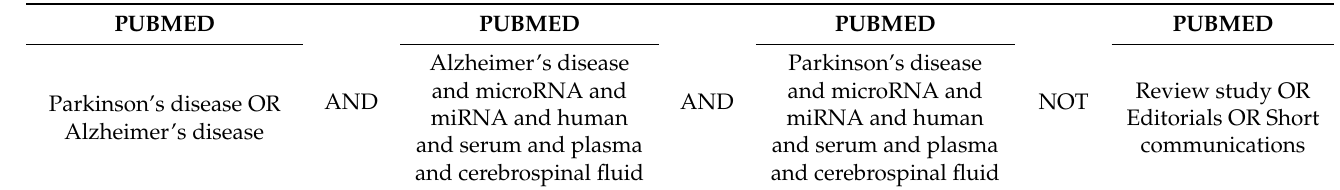
Table 2. For an example of the search structure in PubMed, the same search strategy was used in the other